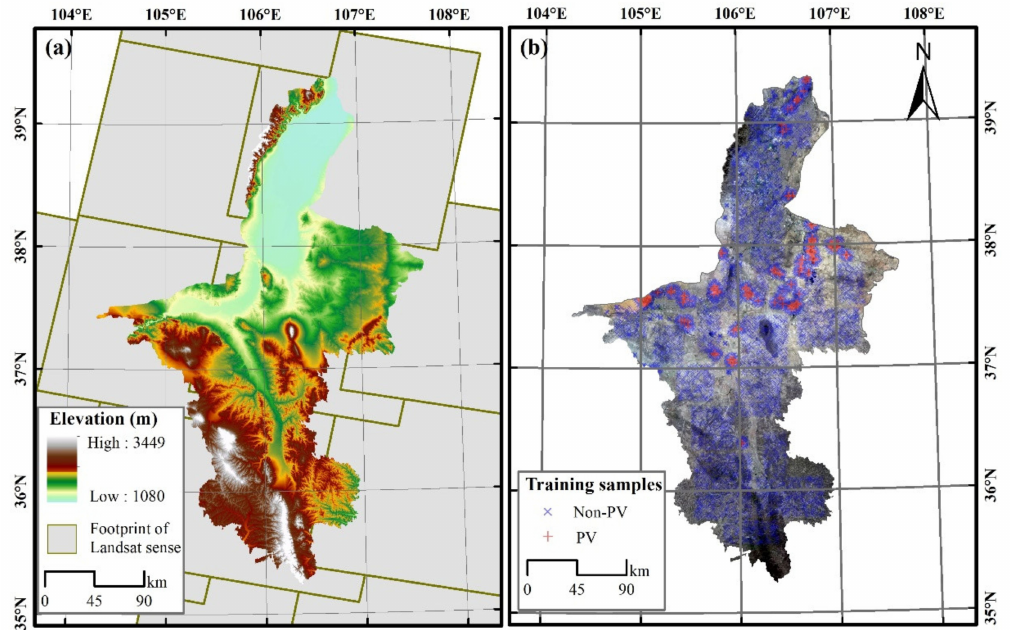
Figure 1. ( a ) The terrain of the Ningxia autonomous region; the gray bounds refer to the footprint of Landsat-8 sense used in this study. The path/row of the senses included 130/032, 130/033, 129/033, 131/034, 130/034, 129/034, 128/034, 130/035, 129/035, 128/035, 129/036, 128/036; ( b ) The true-color image from Landsat-8 over the Ningxia autonomous region and the training samples; the blue cross represents non- photovoltaic (PV) labeled points, while the red cross represents PV